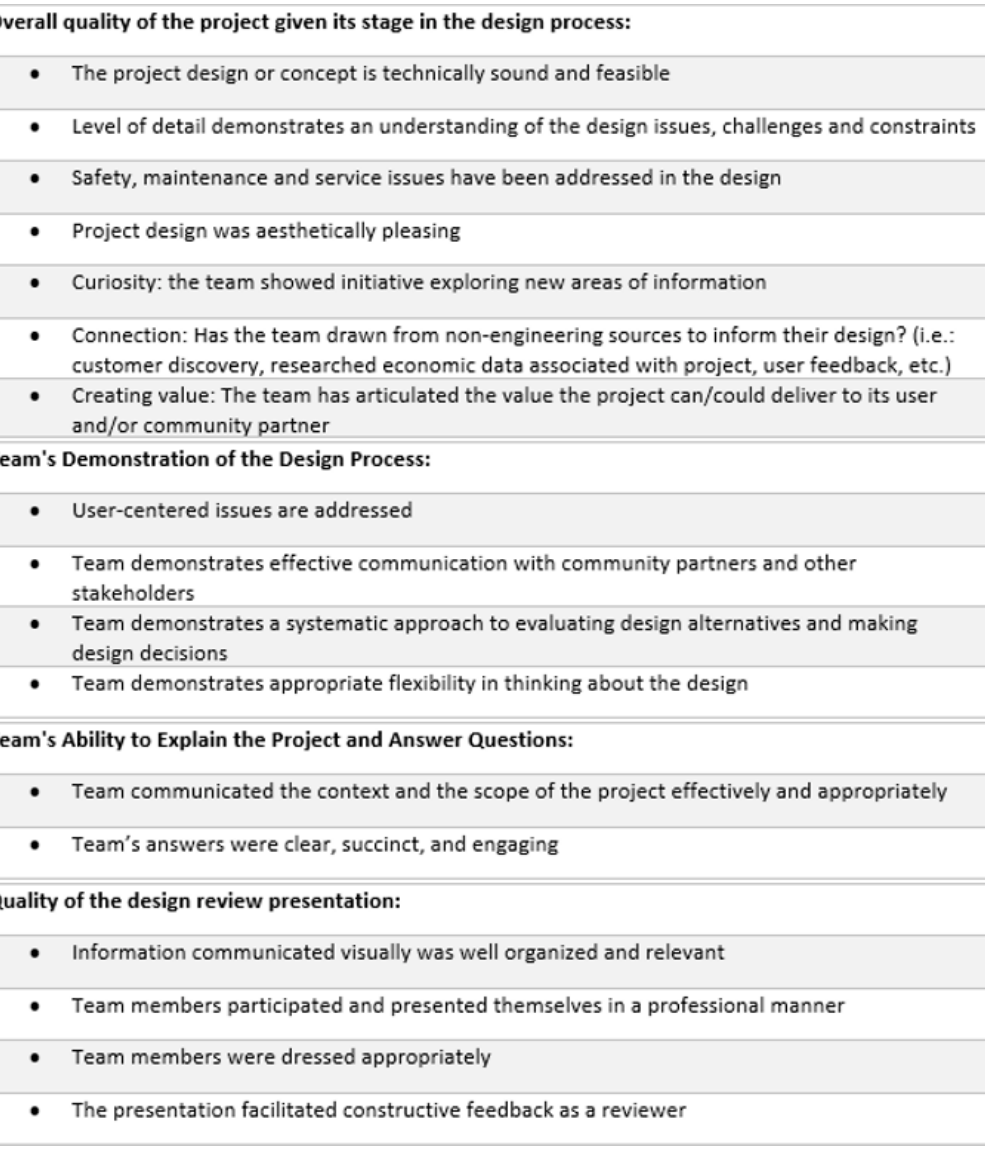
Figure 23. EPICS final showcase competition rubric.